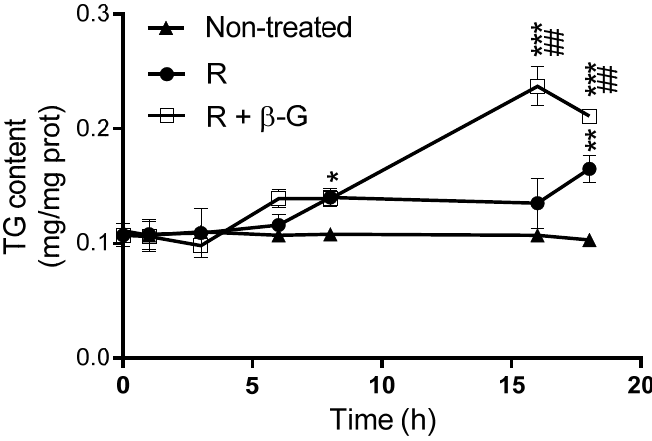
Figure 5. Triglyceride amounts in AML12 hepatocytes exposed, or not, to 0.3 M palmitic acid (PA) with resveratrol (R; 1 µ M), in the presence or not of β -glucuronidase ( β -G; 400 U / mL) over 0, 1, 3, 6, 8, 16, and 18 h. Data are means ± SEM. * p < 0.05, ** p < 0.01 and *** p < 0.001 vs. non-treated cells, and ## p < 0.01 vs. hepatocytes treated with resveratrol alone.